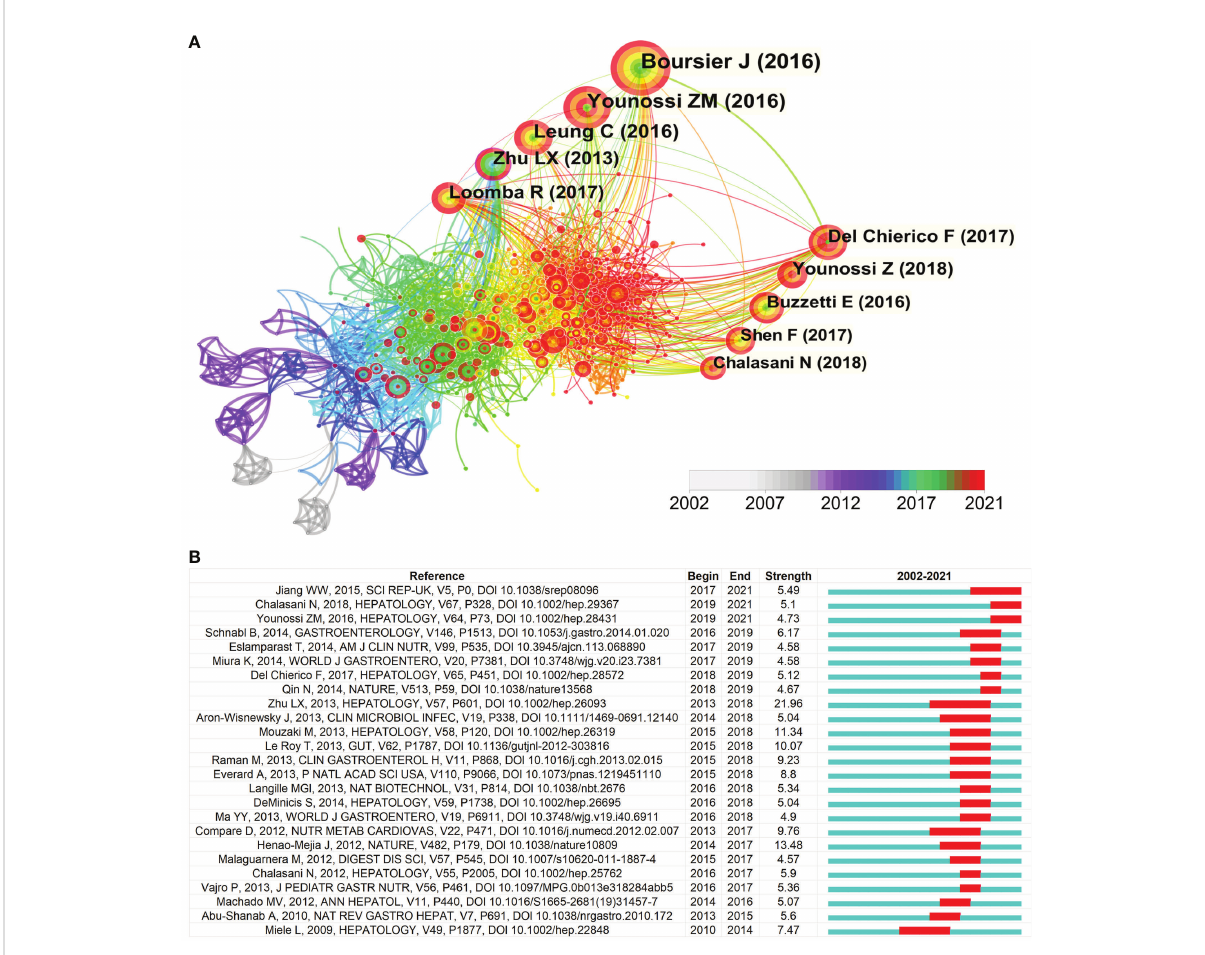
FIGURE 6 Reference co-citation network analysis of publications on the links between the gut microbiota and MAFLD between 2002 and 2021. (A) CiteSpace co-citation map of 20616 references on the links of gut microbiota and MAFLD research, fi lter option showing the largest connected component only. Each node represents a reference and the links between nodes mean these articles were cited as references in the same article within the retrieved 707 articles. The size of the node is positively related to the frequency of citation and line thickness means the correlation with the co-cited papers. The color represents the year of publication as shown in the color bar. (B) Reference with the strongest burst strength of the 707 citing articles on the links of gut microbiota and MAFLD research between 2002 and 2021. Reference marked in red indicates a sudden increase in usage frequency of this reference during that period. Blue represents a relatively unpopular time